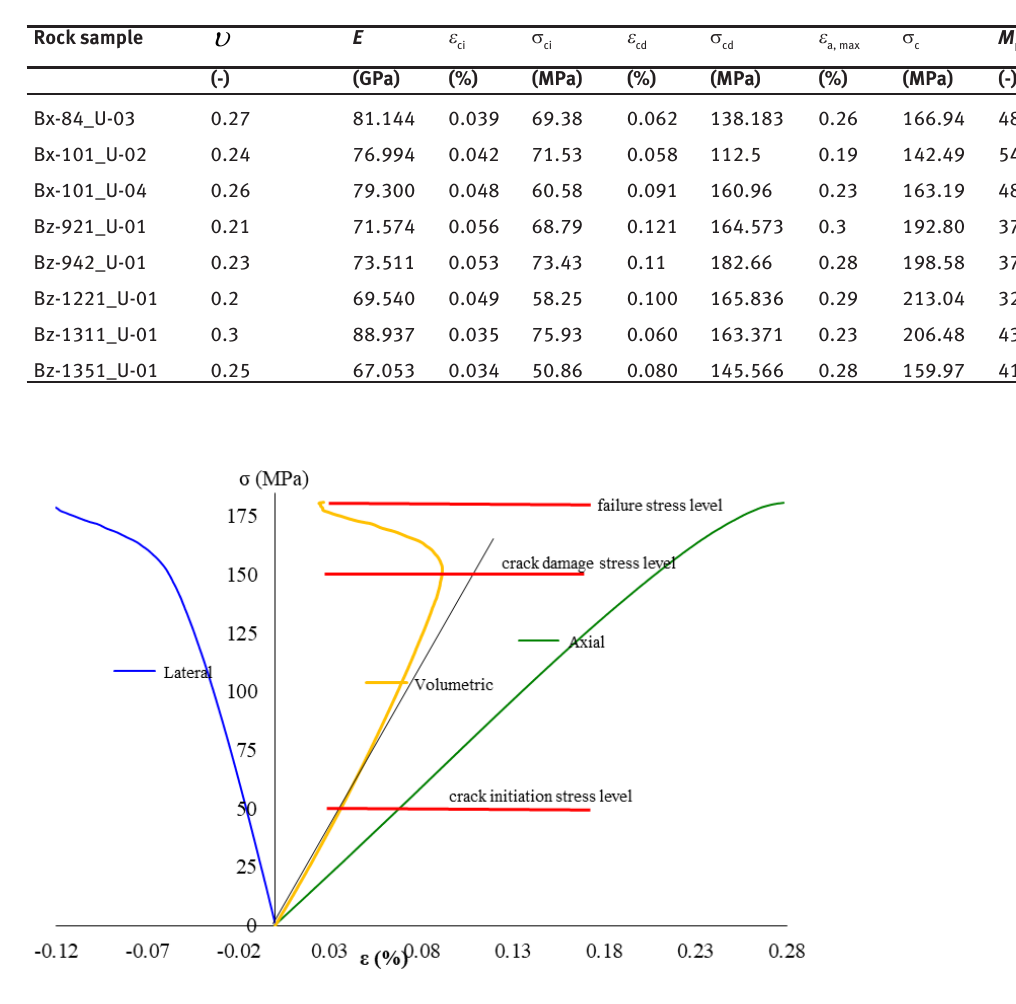
Fig. 7. Poisson’s ratio method for crack initiation threshold determination for Hungarian granitic rock sample (uniaxial compression case)